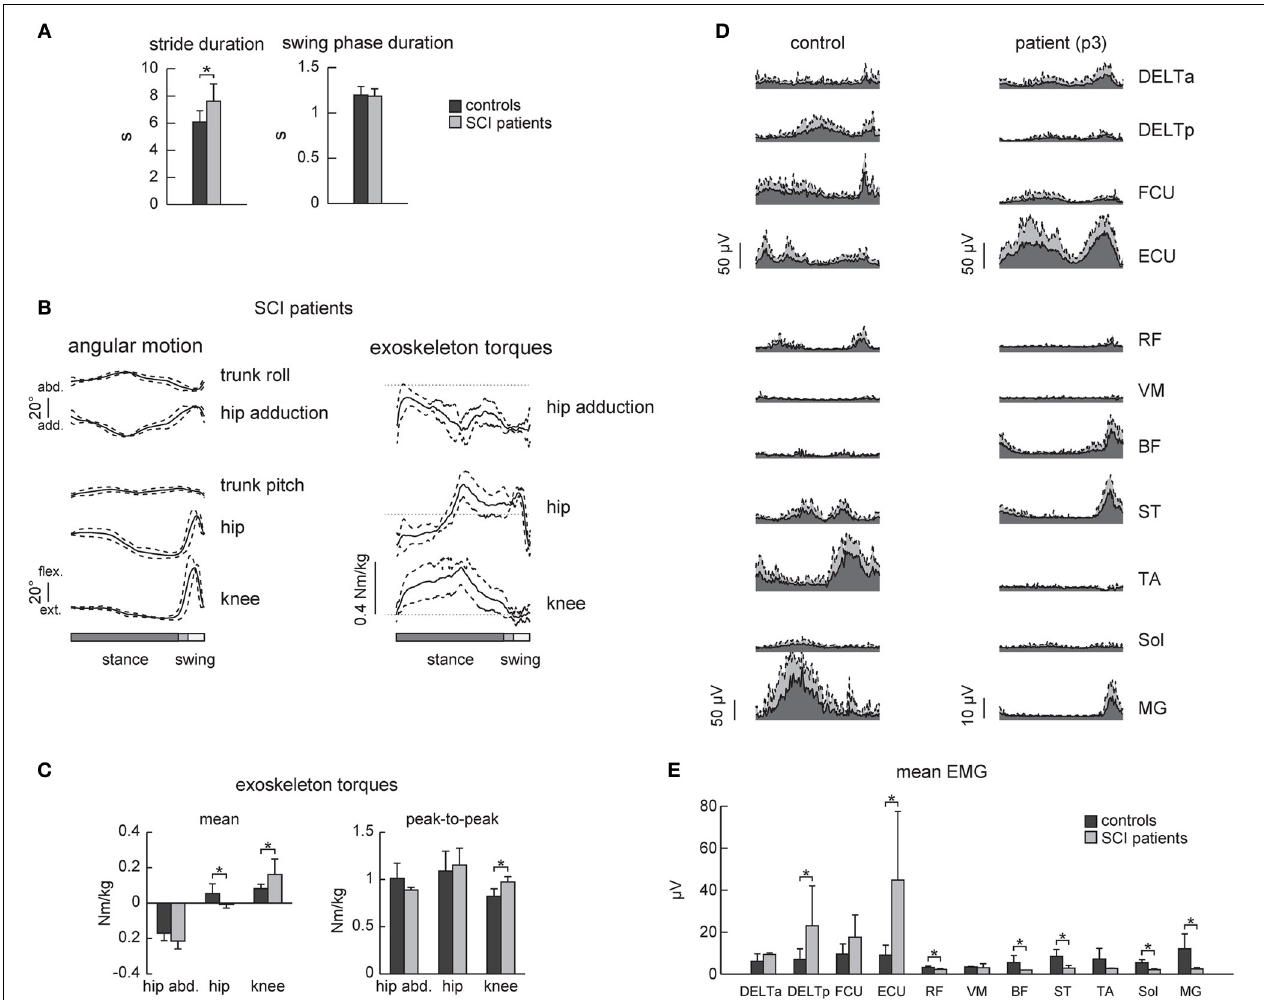
FIGURE 5 | EMG activity in healthy subjects and SCI patients during walking in the exoskeleton (“EXO-assisted” mode). (A) Joint angles and exoskeleton torques recorded in SCI patients during walking in the exoskeleton. The same format as in Figure 2 . (B) Mean torques and peak-to-peak oscillations of torques in control subjects and patients. (C) An example of EMG activity in the upper and lower limb muscles in a healthy